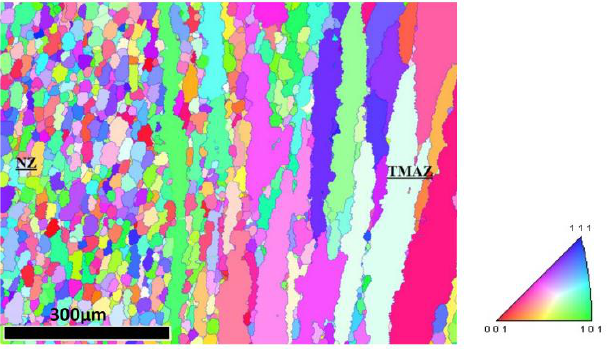
Figure 10. Grain orientation analyzed by Electron backscatter diffraction (EBSD) of NZ and TMAZ (110 mm/min).